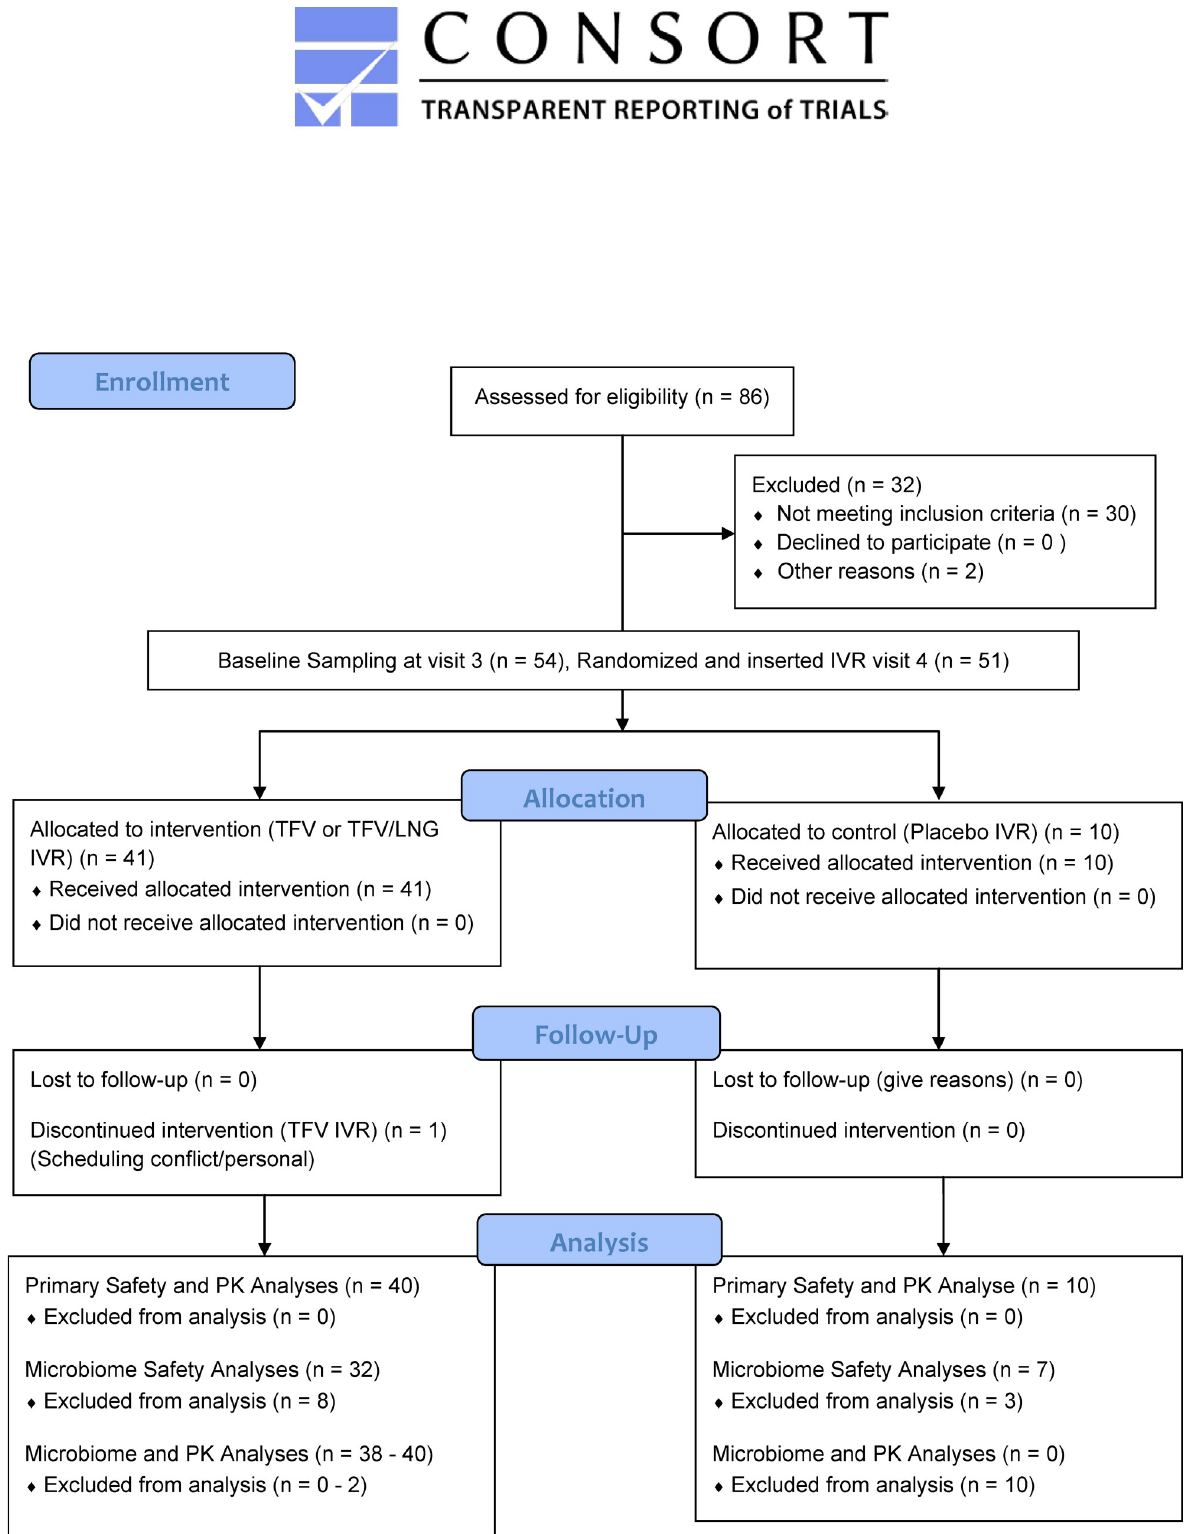
Fig 1. CONSORT Figure CONRAD A13-128 study population.